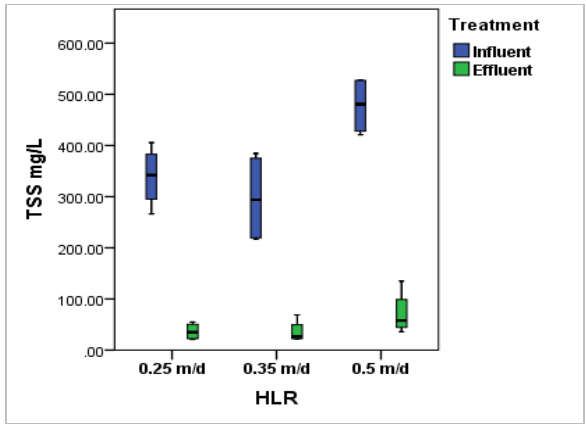
Figure 6. Trend of COD according to HLRs